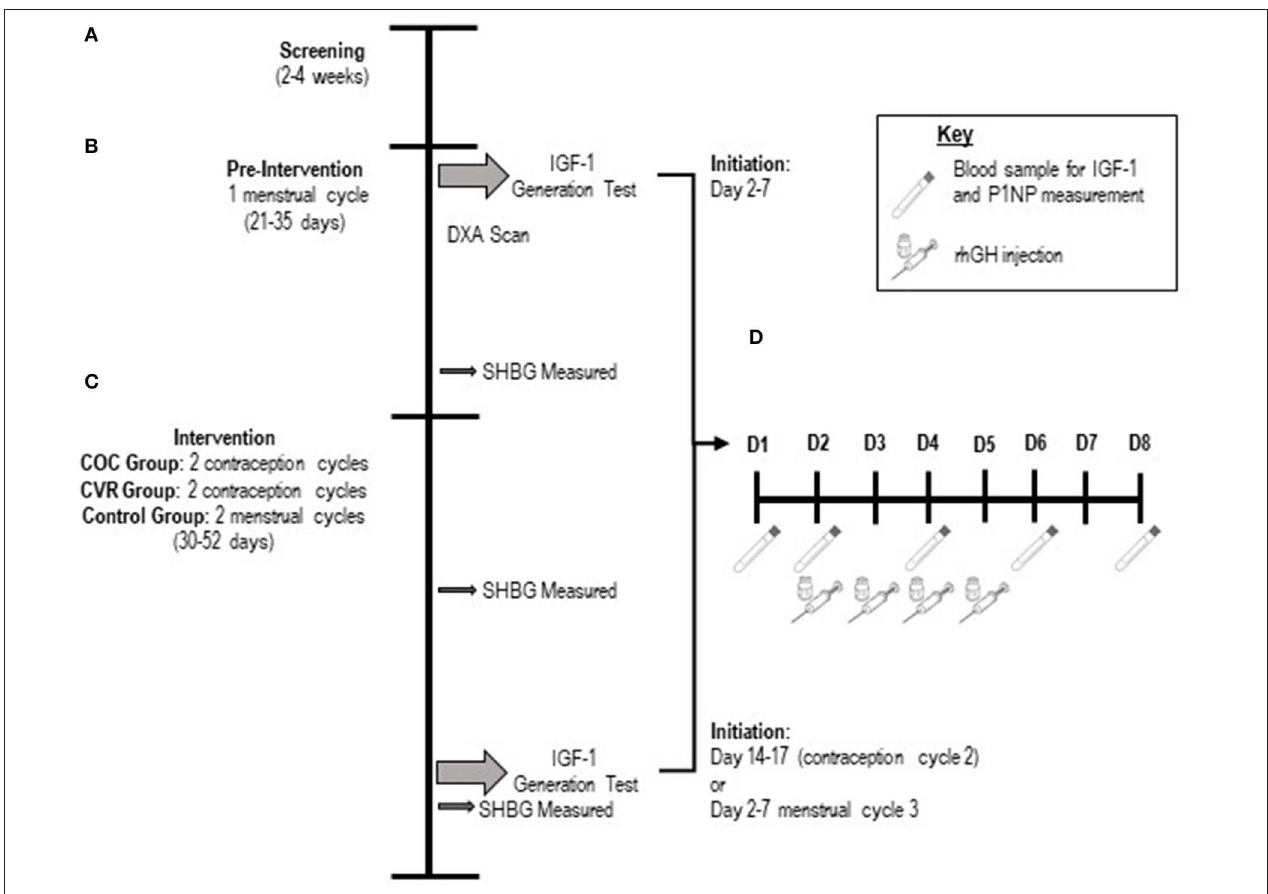
FIGURE 1 | Schematic of the study design. (A) Screening lasted 2–4 weeks. (B) The pre-intervention phase was one menstrual cycle in duration. (C) The intervention phase was two contraception cycles or menstrual cycles in duration. (D) Schematic of the 8-day protocol for the IGF-I Generation Test. Participants had rhGH injections subcutaneously on days 2–5 of the 8-day protocol. Blood samples were taken from participants on days 1,2,4,6, and 8 of the 8-day protocol. COC, combined oral contraception; CVR, contraceptive vaginal ring; DXA, dual x-ray absorptiometry; rhGH, recombinant human growth